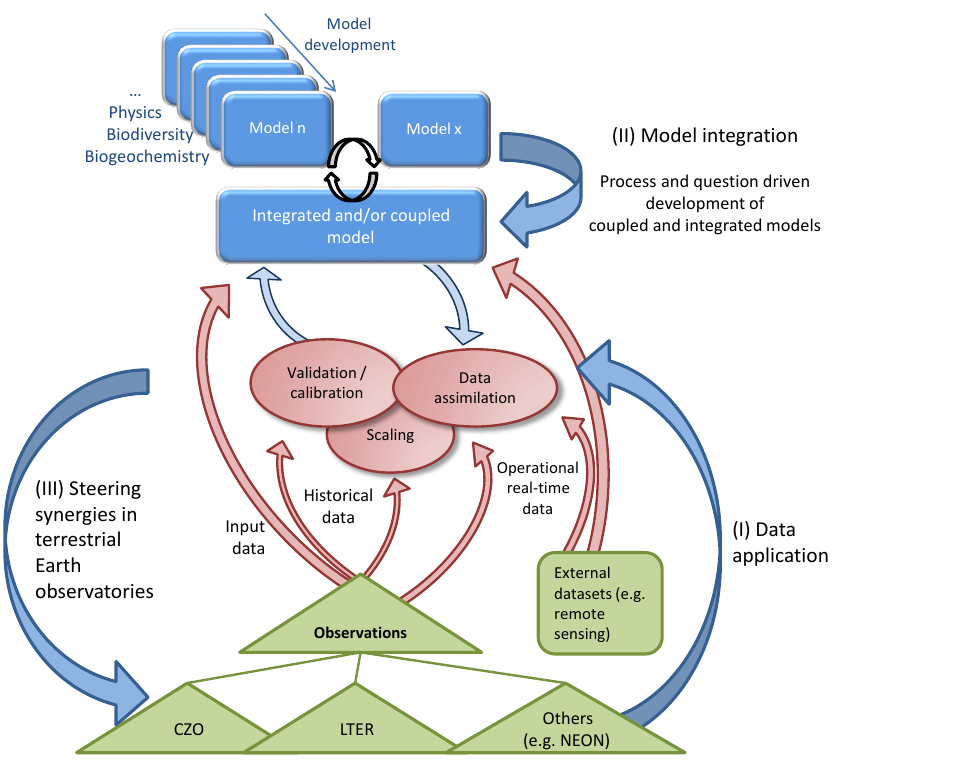
Figure 1. Flowchart of concepts, pathways, and processes of applying terrestrial observatory network data to Earth system dynamics models; identifying the three challenges of (I) data application, (II) model integration, and (III) steering synergies in observation